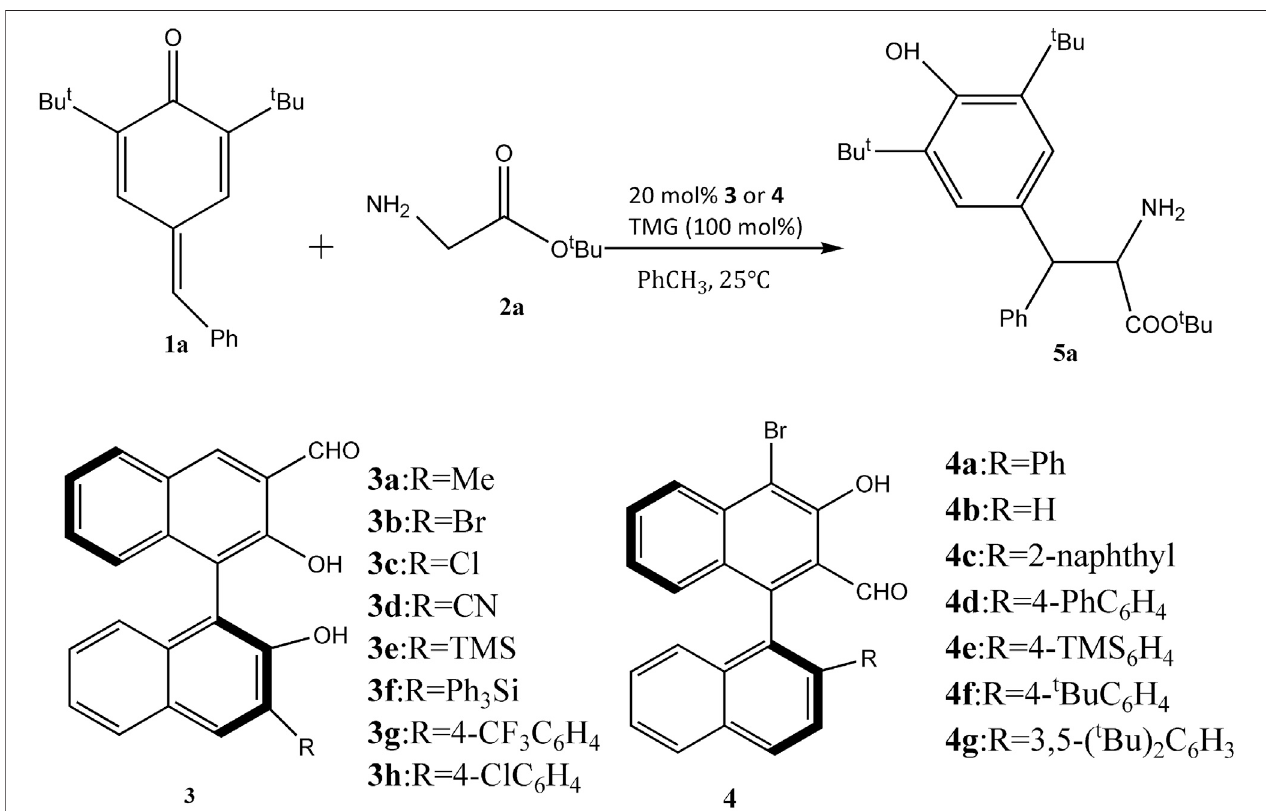
FIGURE 2 | The 1,6-conjugated addition reaction by chiral BINOL aldehyde catalysts (Wen et al., 2020).